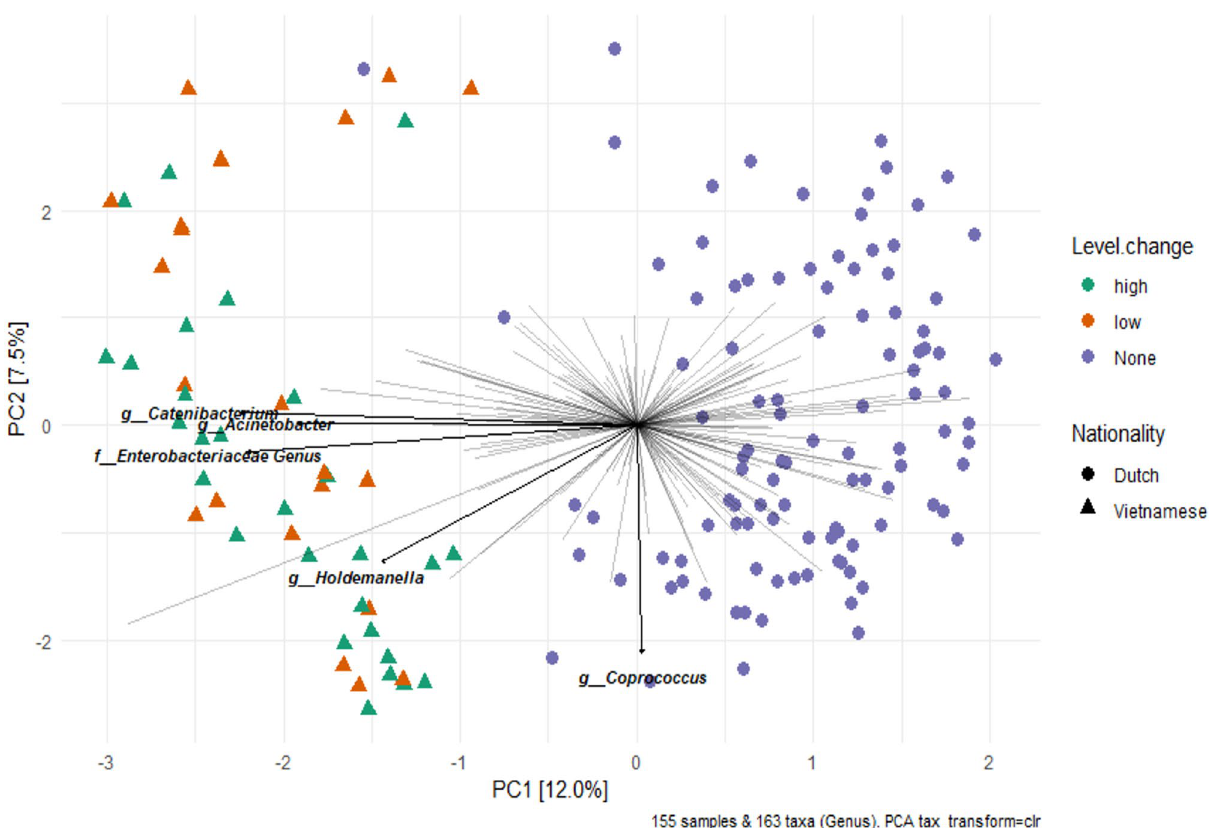
Figure 6. Principal Component Analyses (PCA) comparing the resistance to change of the microbiota of Vietnamese subjects who used antibiotics (both adults and infants, n = 39) to the microbiota of Dutch individuals (n = 106) without antibiotic exposure. Samples of Vietnamese subjects were collected in the month preceding the antibiotic use and are coloured according to the resistance to antibiotics defined as the Aitchison distance between the depicted pre-antibiotic sample and the sample collected after antibiotic use (not depicted in this plot), with a large dissimilarity (within-subject Aitchison distance above the median) depicted as green triangles and low dissimilarity as orange